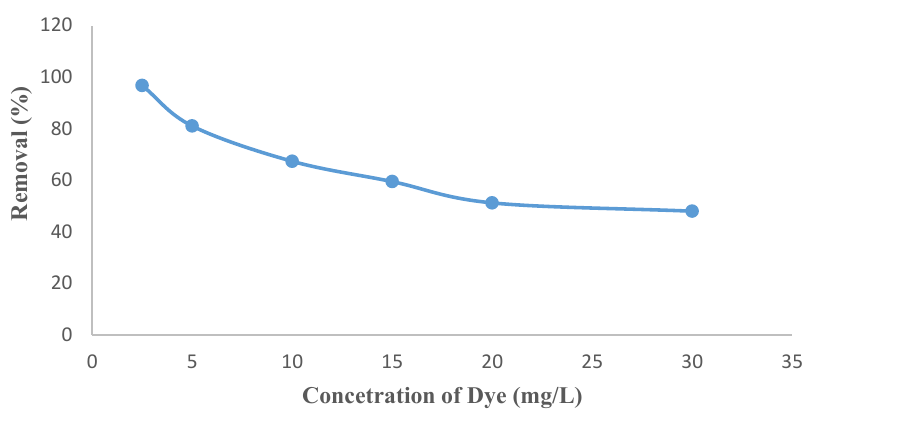
Figure 8. Removal of methyl orange at different concentrations (optimal conditions: pH 3, adsorbent dose 0.2 g, time 20 min, temperature 25°C)